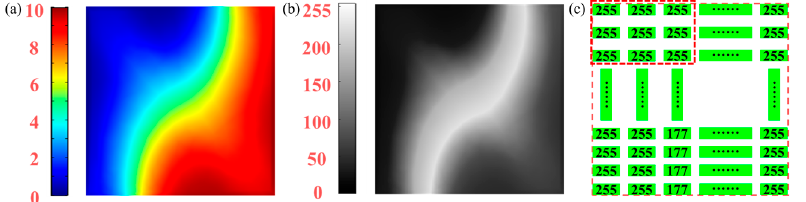
Figure 5. Brief illustration of CLDF with different start position selections: ( a ) RGB image; ( b ) grayscale image; ( c ) gray intensity level matrix.